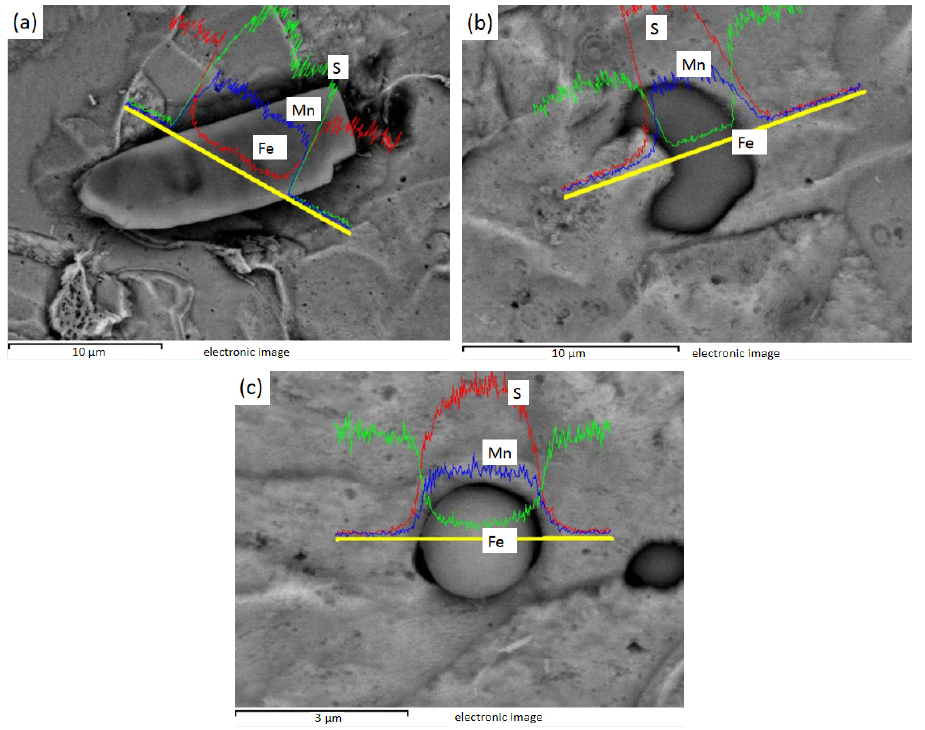
Figure 9. 2# Plate, crescent, and globular MnS inclusions: ( a ) plate MnS; ( b ) crescent MnS; ( c ) globular MnS.